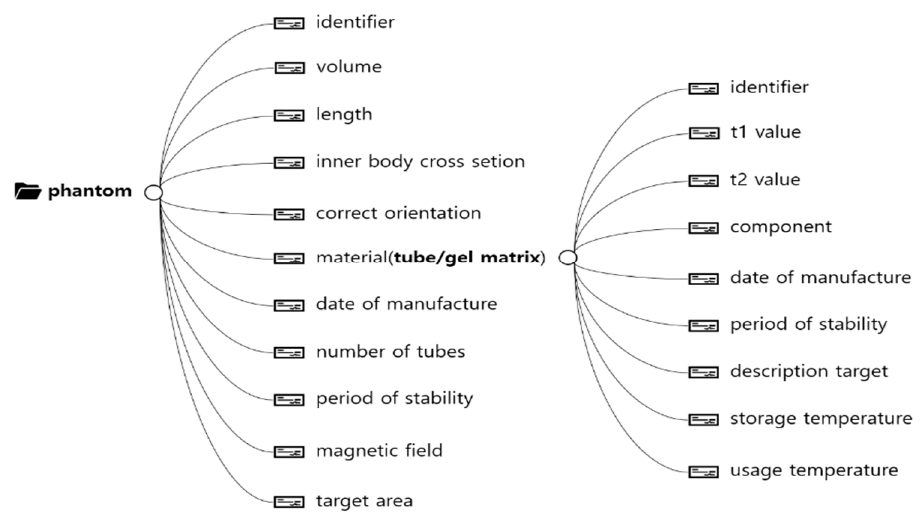
Figure 4. Phantom, Tube, Gel Matrix Data Elements.